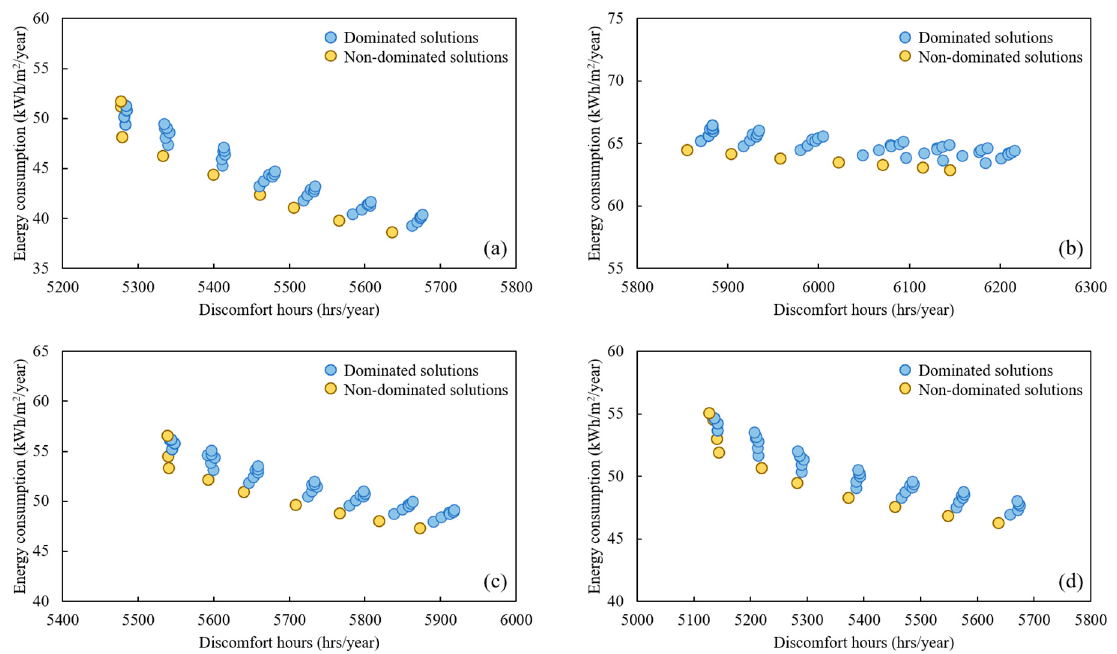
Figure 6. Trade-off between annual discomfort hours and net thermal energy consumption with the variations of U in and SHGC out for NoVent-DSF (cold months, Canberra) and NatVent-DSF (hot months, Canberra) for different orientations: ( a ) North, ( b ) South, ( c ) East, and ( d ) West. Furthermore, the details of the optimal solution for the BIPV-DSF for different ori- entations in Canberra are given in Table 9, which shows the exact same optimal U in and SHGC out values as that of the Sydney case; that is, U in of 5.87 W/m 2 K and SHGC out of 0.81 were optimal values for the most orientation scenarios of the BIPV-DSF within the solution space, except for the south-facing scenario where the optimal U in was 5.16 W/m 2 K